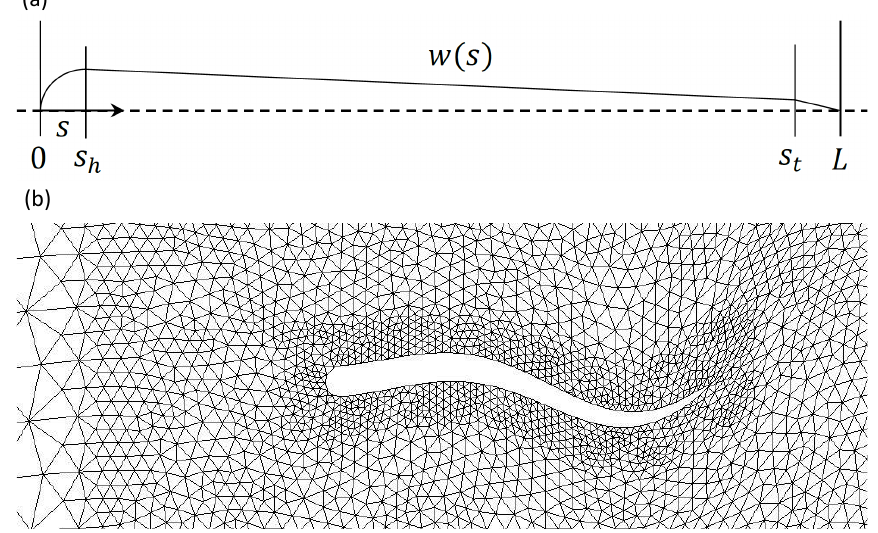
Figure 1. Illustration of the analytical description of the fish-like robot body. ( a ) Half outline of the body; ( b ) mesh distribution around the